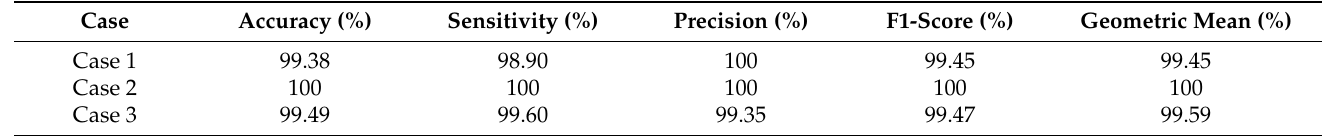
Table 1. Model performance metrics (%) obtained for various